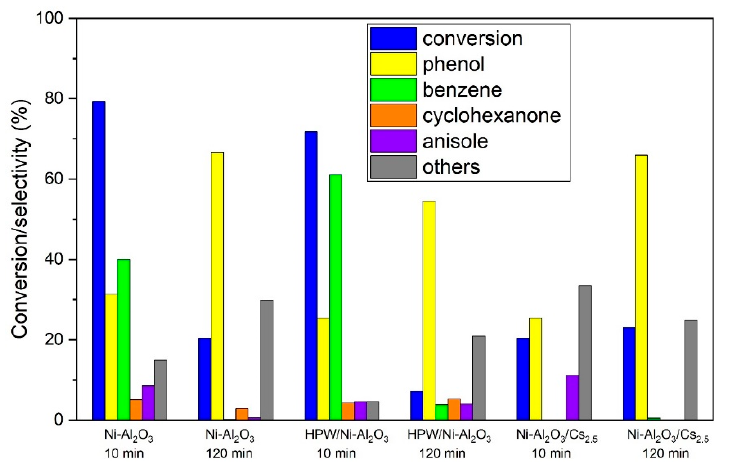
Figure 11. Conversion and products selectivity for 10 and 120 min of TOS for HDO of guaiacol with the Ni-Al 2 O 3 catalysts series.